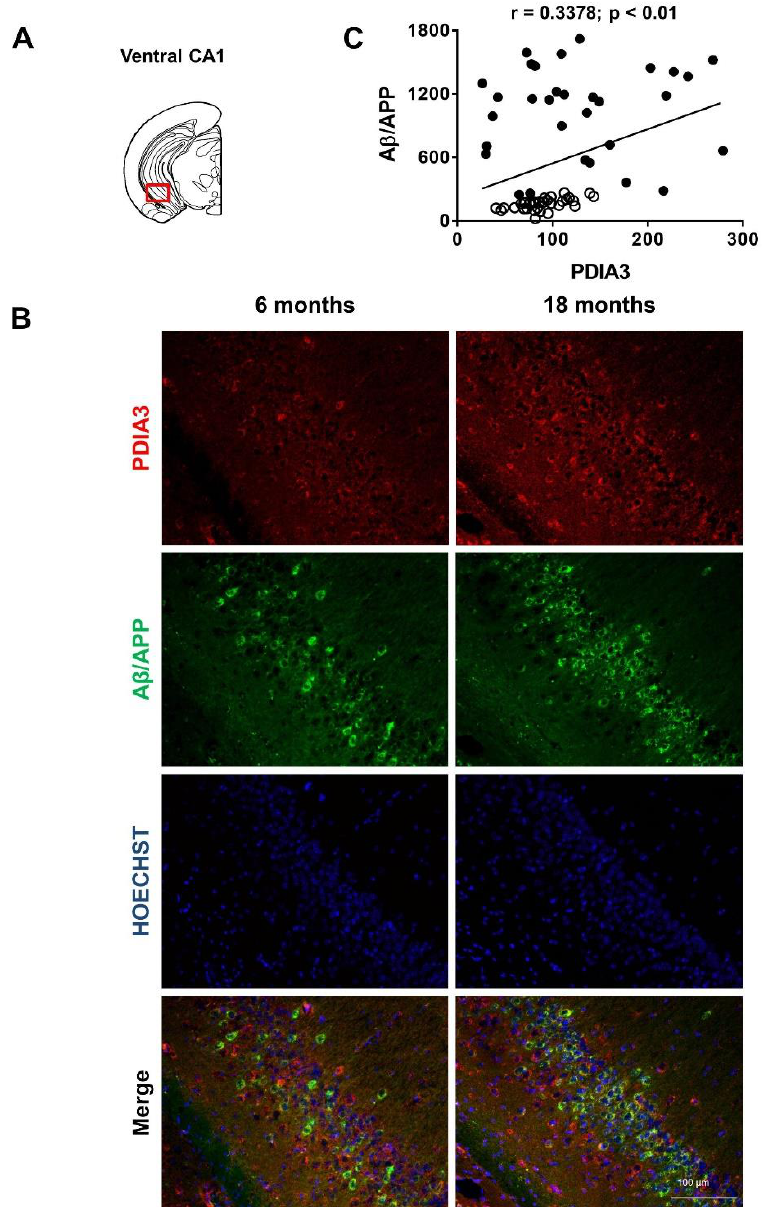
Figure 5. A β /APP-PDIA3 protein levels observed in the ventral CA1 region of hippocampus of 3 × Tg-AD mice: ( A ) The brain diagram illustrates the site where the representative microphotographs of the ventral CA1 region of hippocampus were taken; ( B ) Representative microphotographs of A β /APP-PDIA3 double-fluorescent immunostaining (green and red, respectively) performed on brain slices of ventral CA1 region of hippocampus collected from 6- and 18-month-old 3 × Tg-AD mice. Hoechst (blue) was used as fluorescent counterstain. Original magnification: 20 × ; scale bar was set at 100 µ m; ( C ) Scatterplot of A β /APP vs. PDIA3 protein levels in the ventral CA1 region of hippocampus of 6- and 18-month-old 3 × Tg-AD mice. A β /APP and PDIA3 levels refers to the results obtained by the semiquantitative analyses of the fluorescence signals as optical densities within the same cell and under the same exposure conditions. Open circles: 6-month-old 3 × Tg-AD mice; closed circles: 18-month-old 3 × Tg-AD mice. Data are expressed as mean optical densities ± SEM. Statistical significance threshold was set at p < 0.05.